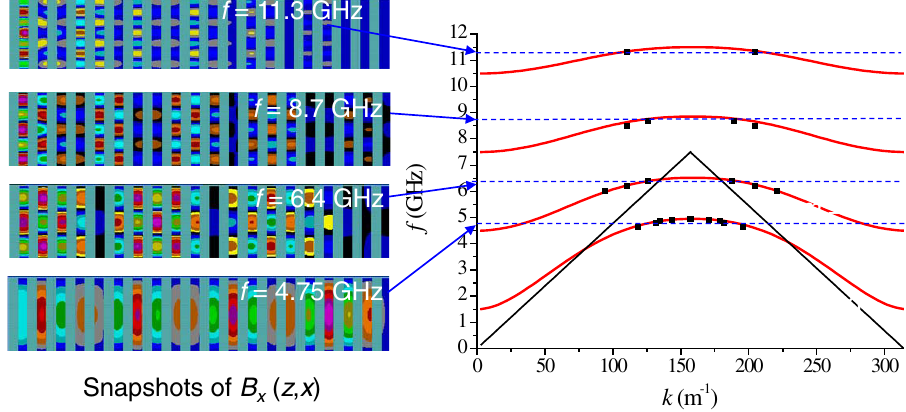
FIG. 8. Simulated contour plots of B in the x - z plane ( y ¼ (cid:1) 1 mm ) at fixed time, generated by a current driver operating at fixed x frequencies in each of the four lowest symmetric modes. The grating has sidewalls, where B the theoretical 3D dispersion relation (red). Some results of simulations where the wave numbers k were determined are indicated by